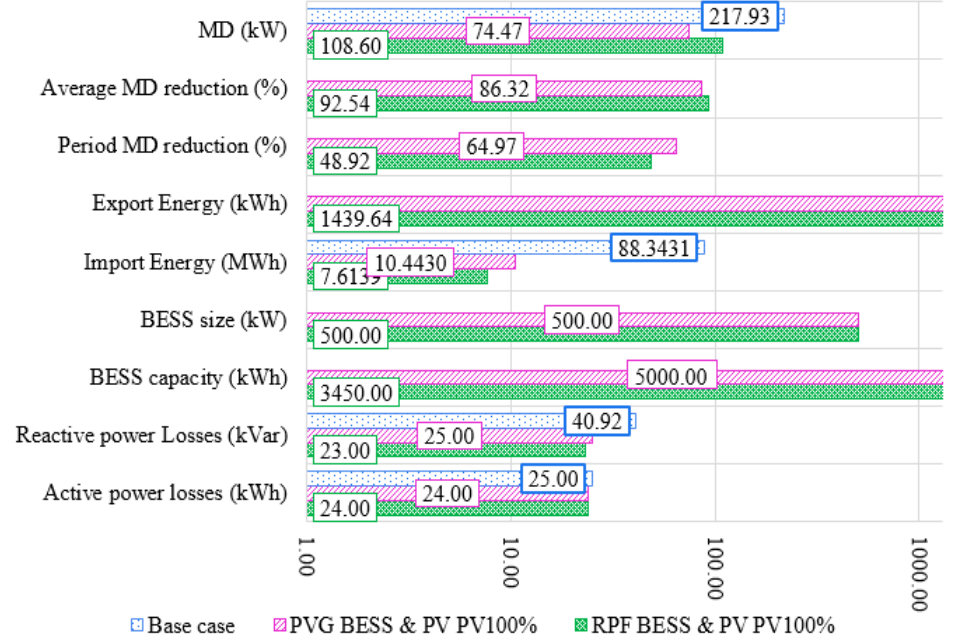
Figure A4. Comparison of PVGS and RPFS with 100% PV penetration level (January 2016).